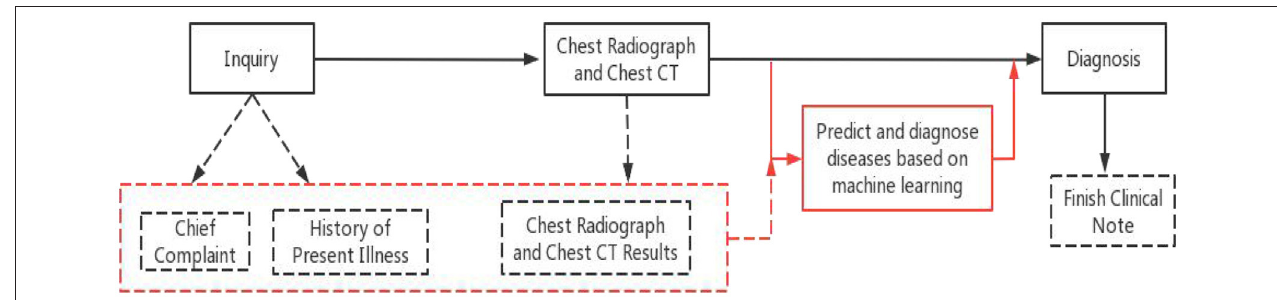
FIGURE 1 | Original diagnostic procedures and our proposed method. Black solid line and boxes are original procedure, black dashed lines and boxes are generated clinical notes at each step. Red solid lines are the additional step of using the proposed method and the red dashed box and line are the existing clinical notes used by the proposed